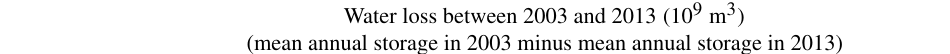
Table 3. Water loss in the storage compartments of Lake Urmia basin between 2003 and 2013 as observed and simulated by the WGHM variants that were calibrated using different observation